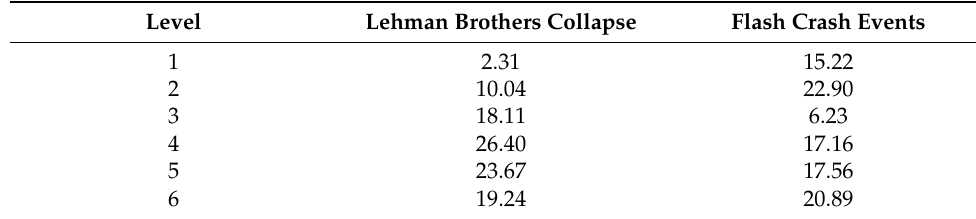
Table 5. Power spectra for VZ stock market data.